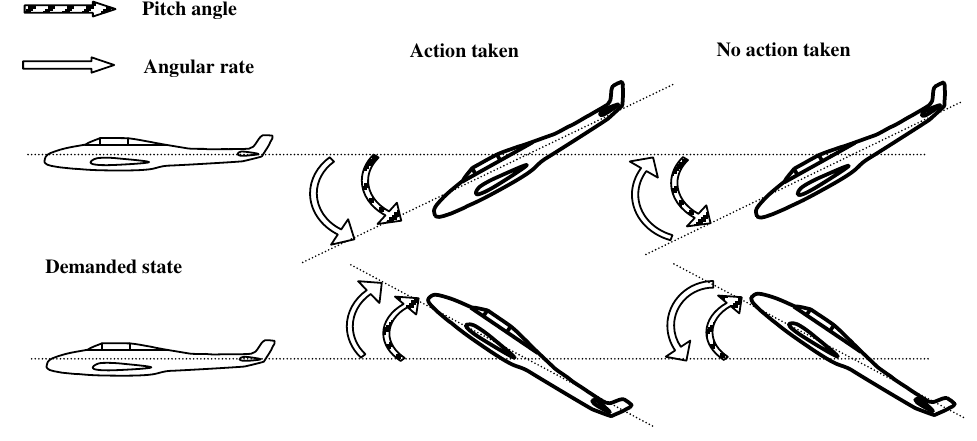
Fig 5. When pilots correct flight - as a sample pitch angle channel